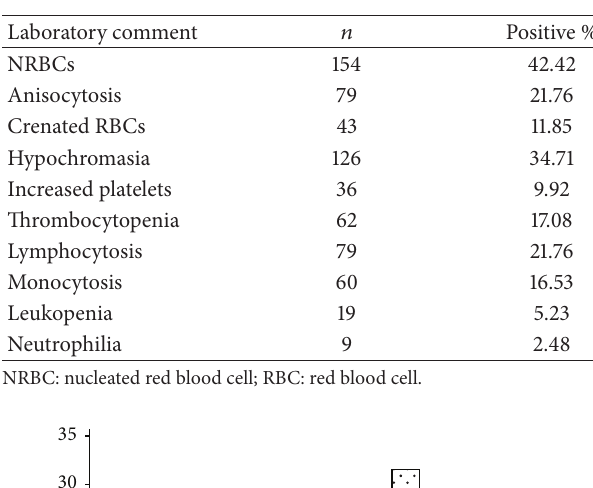
Table 4: Most commonly used therapeutic agents to manage cases of canine babesiosis in